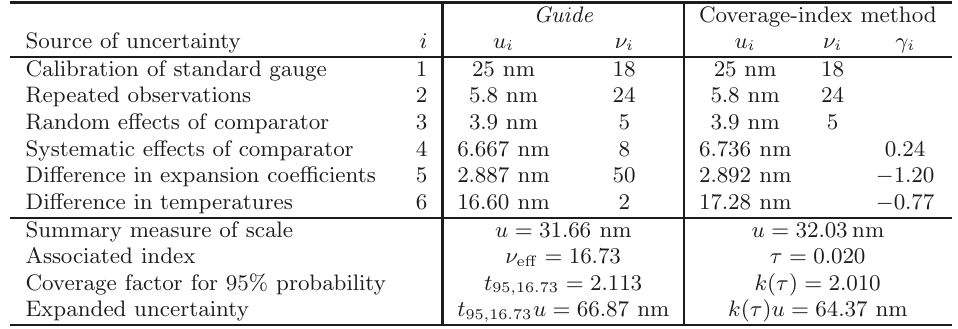
Table 1. Summary of an example analysis for the method of the Guide and the coverage-index method. Guide Coverage-index